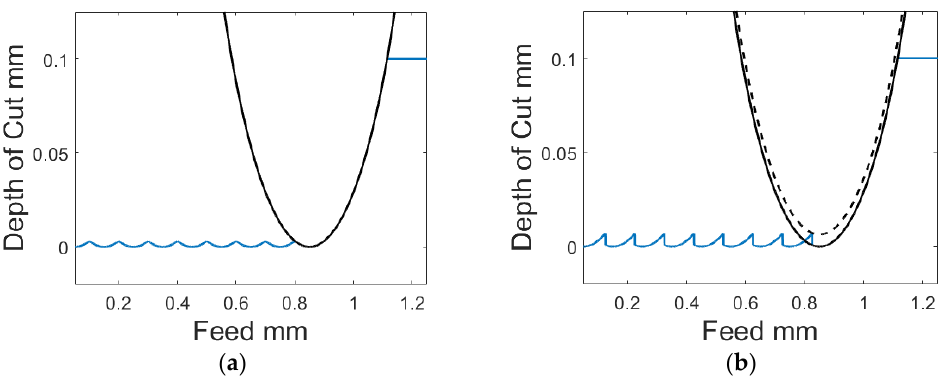
Figure 1. ( a ) Simulated surface from turning, created assuming perfect chip removal; ( b ) Simulated surface created by assuming material in the Spanzipfel region is left on the surface and behaves